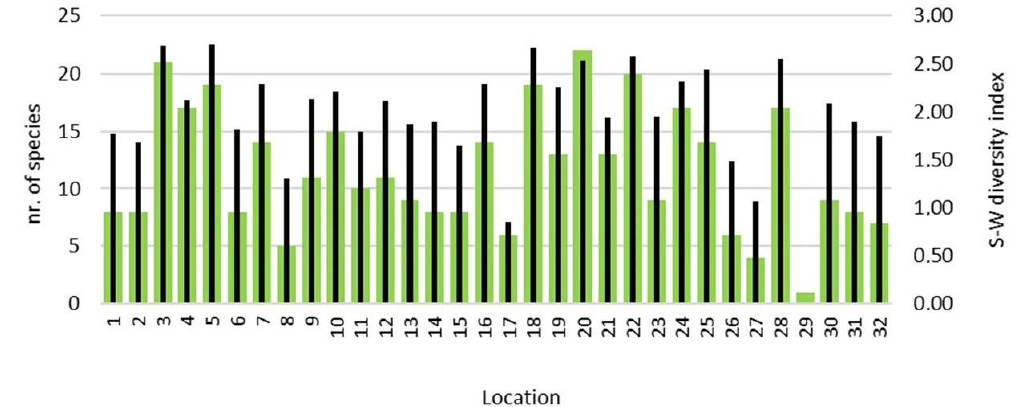
Figure 2. Total species number (green bars) and Shannon–Wiener (S–W) diversity index (black lines) in surveyed waterbodies.